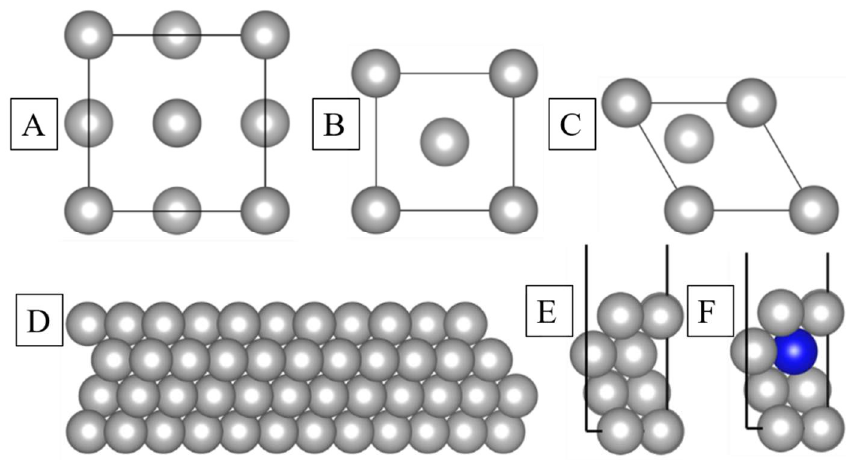
Figure 1. Unit cells of bulk ( A ) face centered cubic (FCC), ( B ) body centered cubic (BCC) and ( C ) hexagonal closed packed (HCP) crystal structures, ( D ) a low index (111) surface of FCC crystal, ( E ) a four layer 2 × 2 unit cell of (111) surface of FCC crystal and ( F ) a four layer 2 × 2 unit cell of (111) surface of a bimetallic alloy. Grey: host atom and dark blue: guest atom.